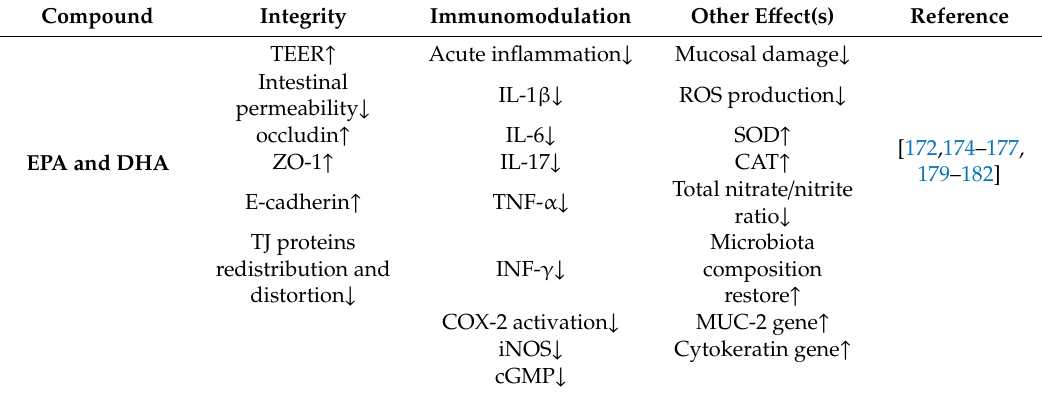
The e ff ects of polyunsaturated fatty acids (PUFA) on intestinal integrity and